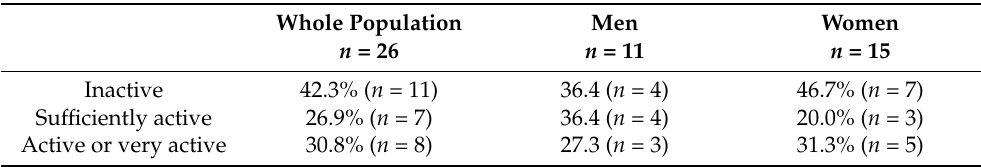
Table 5. Classification of the study population by degree of physical activity based on the International Physical Activity Questionnaire Short Form Figure 2. Percent energy from macronutrients in the study population of patients with type I Gau- cher disease (total energy intake 2091 kcal/day).